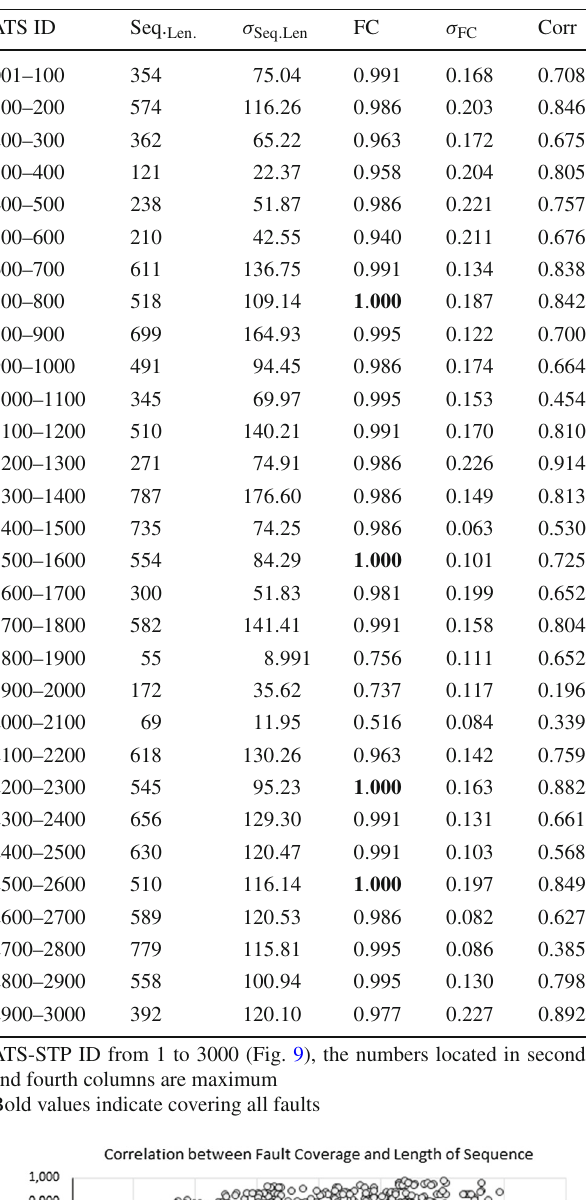
Table 2 ATS statistical results for s208.1 circuit